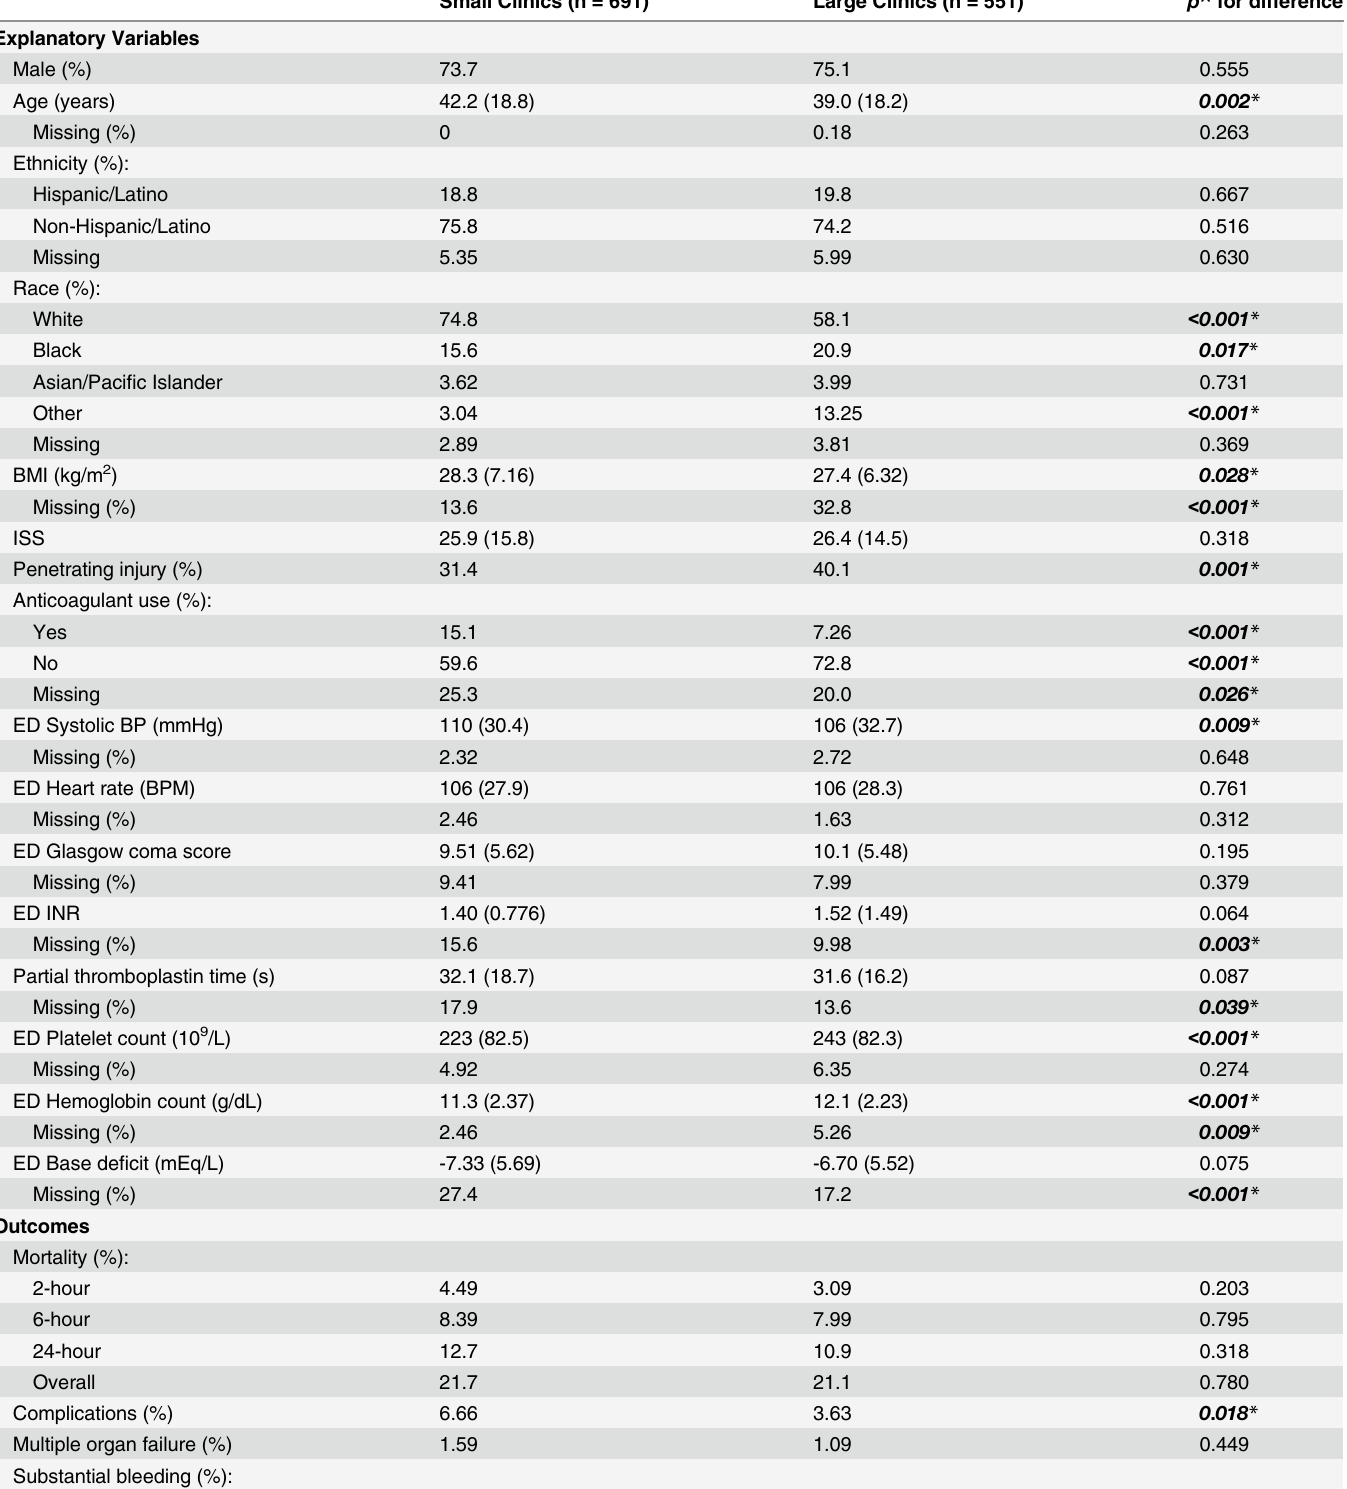
Table 1. Summary statistics. Summaries are presented as percent where indicated, and mean (standard deviation)